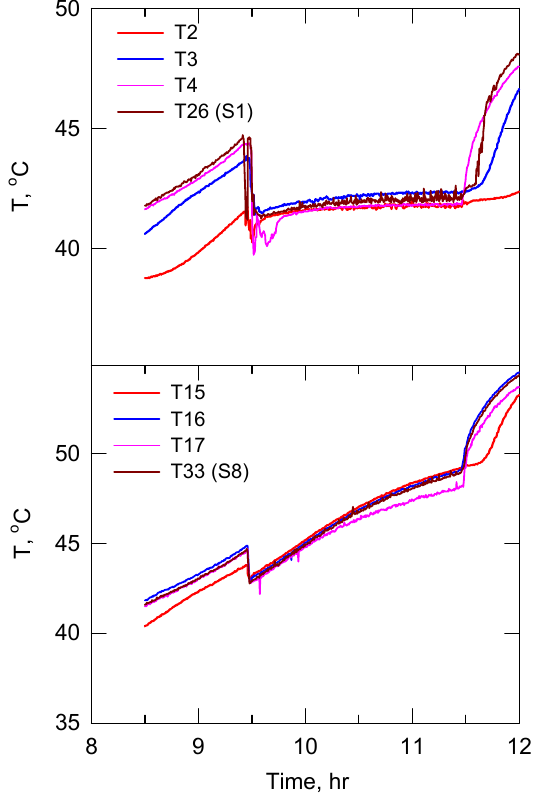
Figure 9. Temperature variation in the tanks 1 and 8, 10 LPM case.